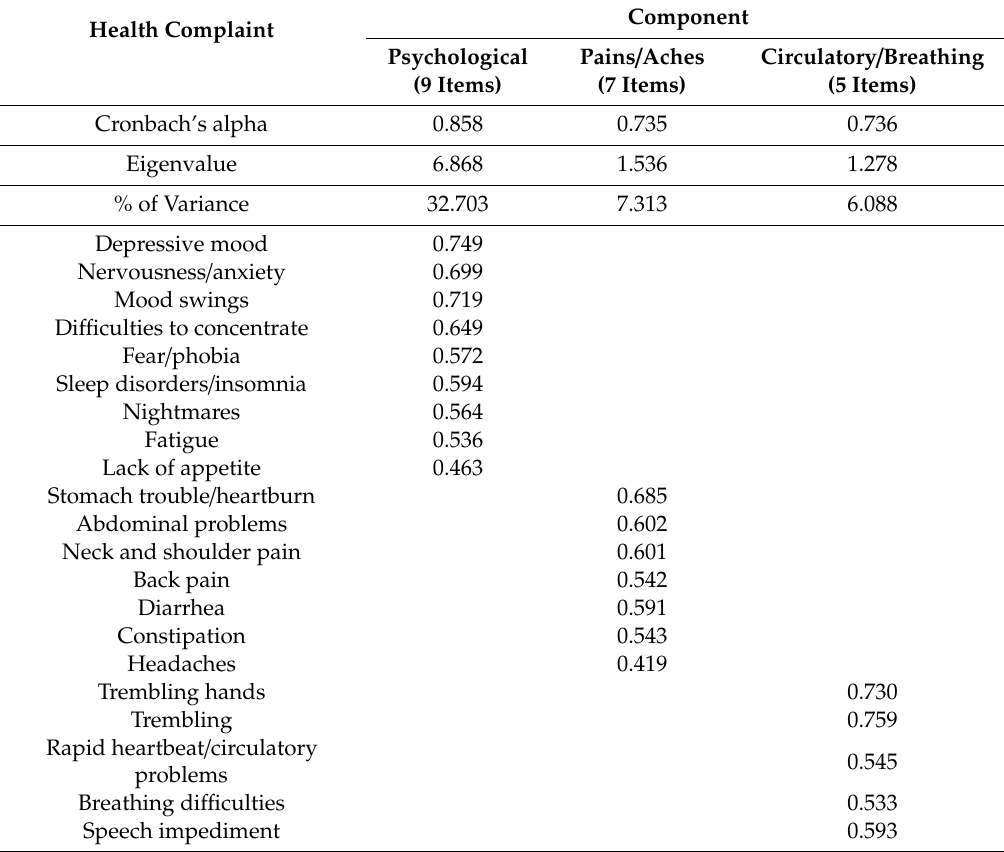
Table 2. Factor analysis and loading using varimax rotation of 21 self-reported health complaints into three components.